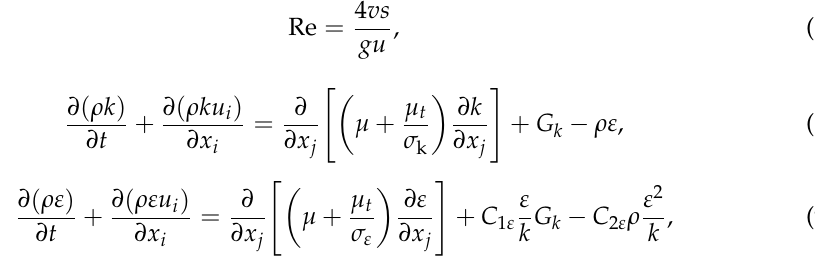
Table 4. Parameter meaning of control equation of standard k- ε model. Parameter Meaning s cross-section area of roadway u roadway cross-section perimeter g viscosity coefficient of fluid motion σ k empirical constant, take 1.0 C 1 ε empirical constant, take 1.44 C 2 ε empirical constant, take 1.92 σ ε empirical constant, take